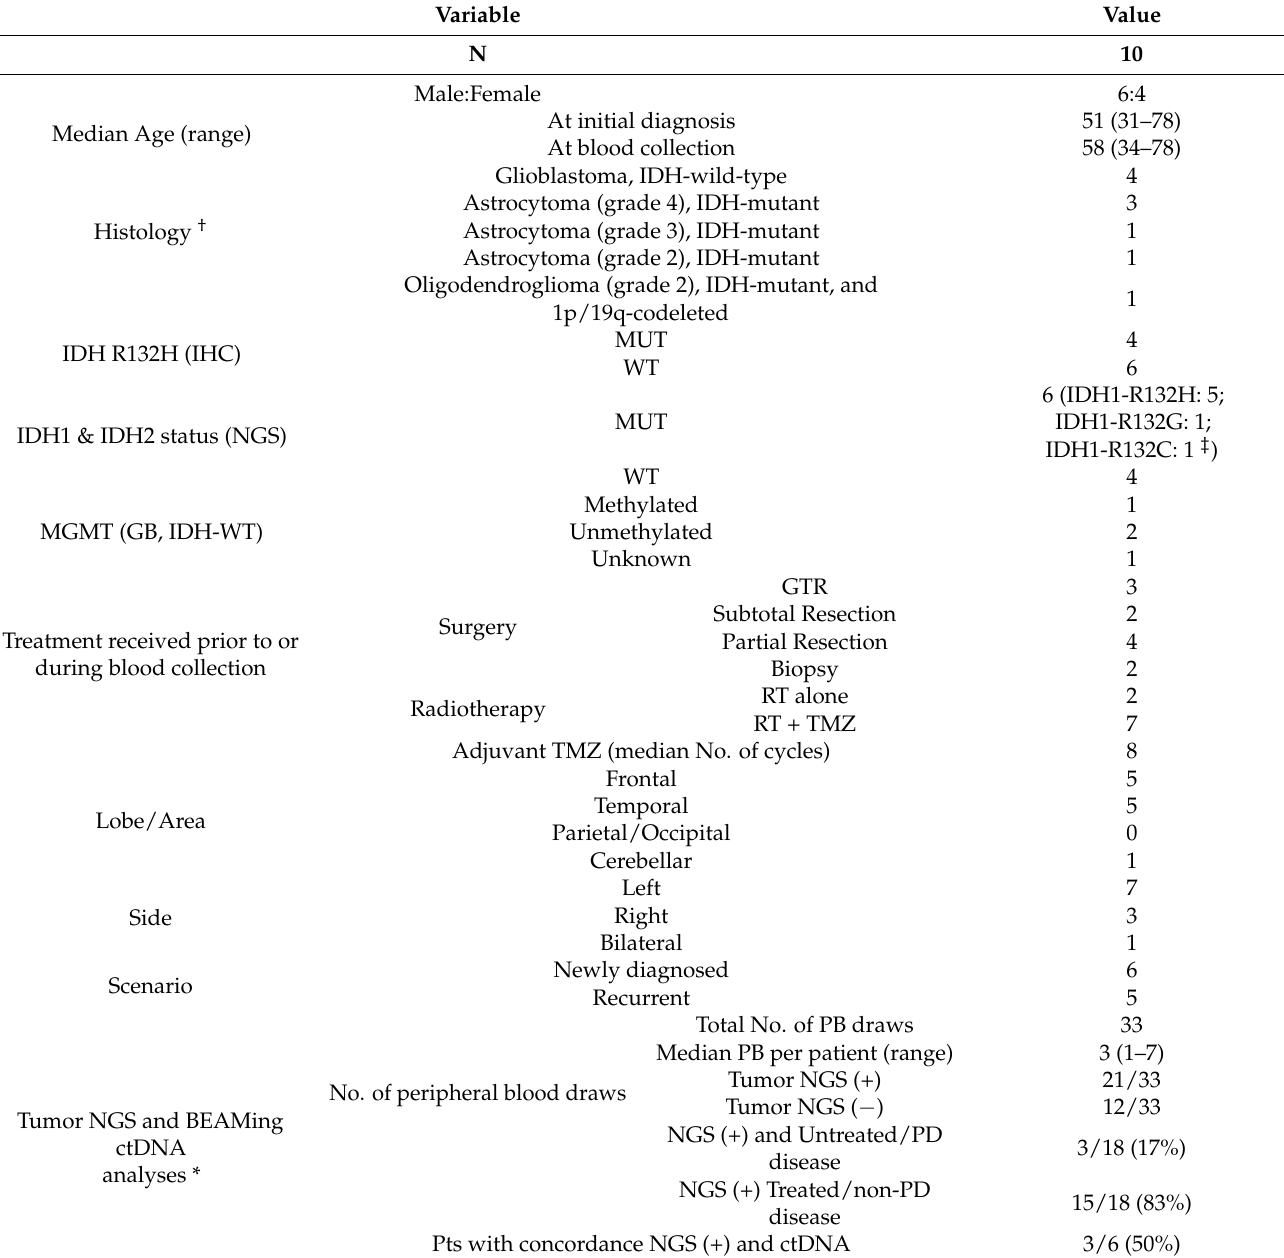
Table 1. Summary of patient characteristics at the time of IDH1 mutational study in